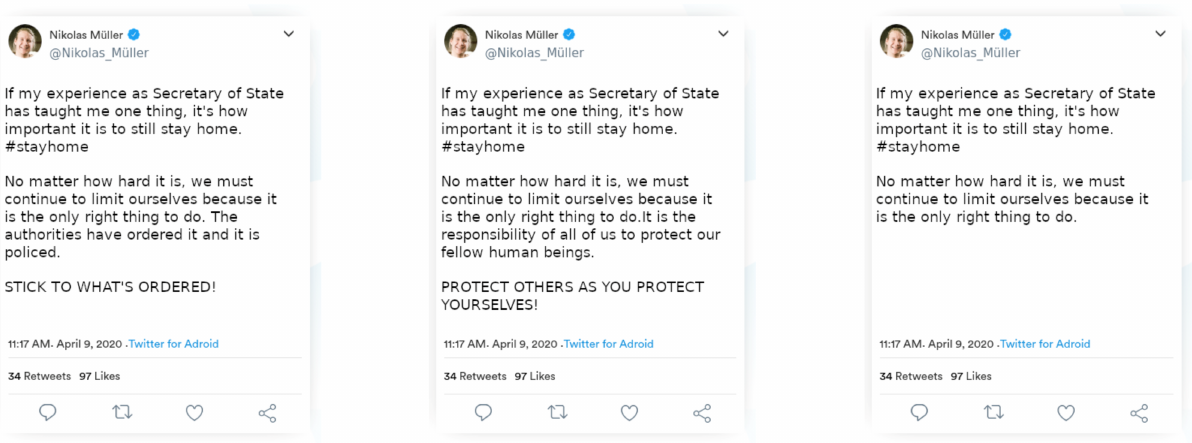
Figure 1. Twitter messages (translated to English) in three framings (from left to right: authoritarian message framing, moral message framing, and neutral message framing for control) sent by the state secretary (authoritarian sender); the social worker had the same